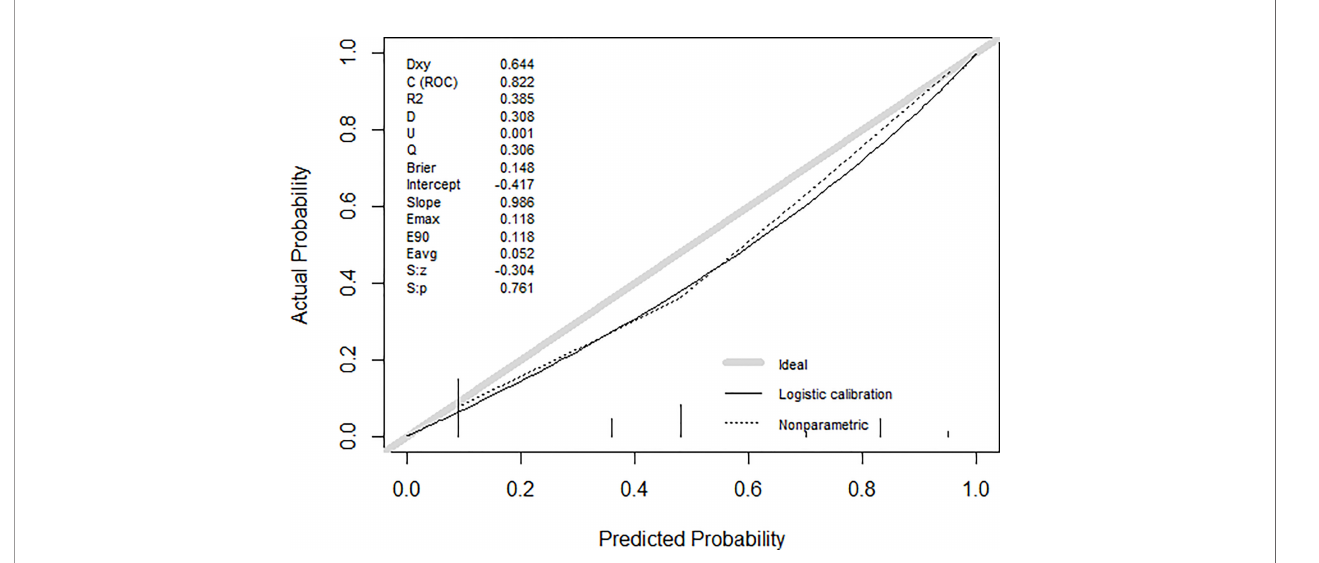
FIGURE 2 | The calibration curves of the nomogram for the probability of ALNM.